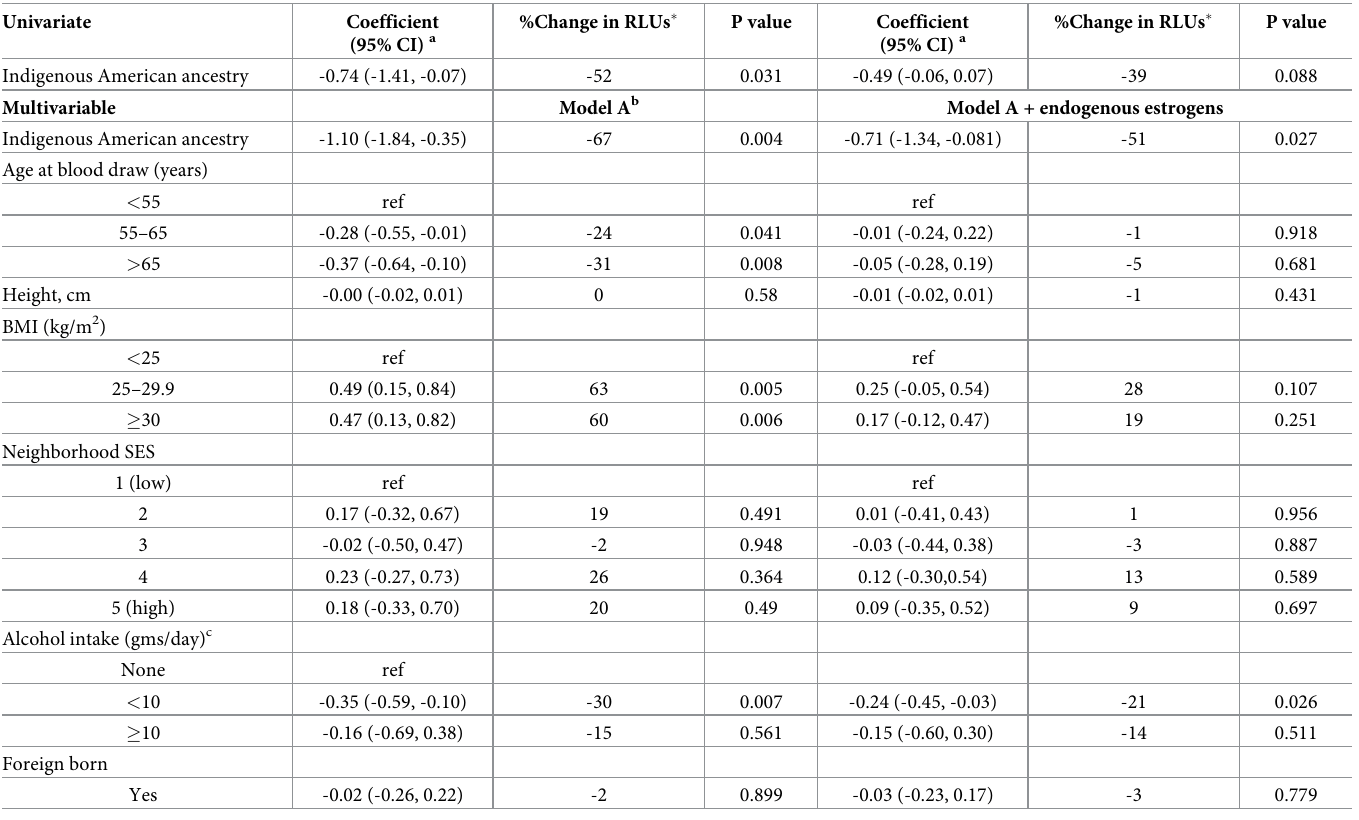
Table 3. Association between estrogenic activity and Indigenous American ancestry in Latina women (N = 276) using univariate and multivariable analysesUnivariate.